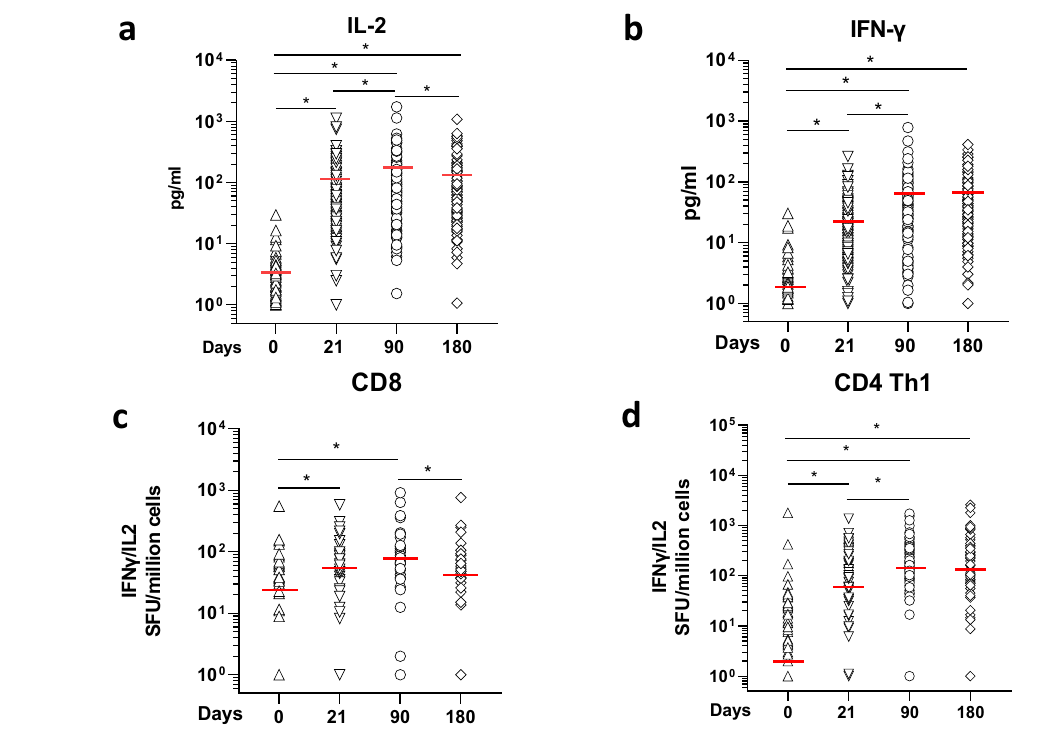
Fig. 5 | Anti-SARS-CoV-2 spike protein T cell responses. a IL-2 and b IFN- γ secretion pro fi le of whole-blood cultures stimulated with S protein peptide pool compared at different time points of paired samples from vaccinated individuals ( n =160).Thelimitofdetectionforeachcytokine(IL ‐ 2=5.4pg/ml;IFN ‐ γ =1.7pg/ml). Values below limit of detection levels were plotted as 1. * p <.001, ANOVA on log- transformed data, which follow a normal distribution. The mean values of each group are represented by a red line and were at day 0, 21, 90 and 180: 1.8pg/ml, 23.8pg/ml, 55.4pg/m and 57.2pg/ml for IL-2; 2.96pg/ml, 102.6pg/ml, 154.2pg/ml and 123.9pg/ml for IFN ‐ γ , respectively. Kinetics of Spike-protein-speci fi c CD8 c or